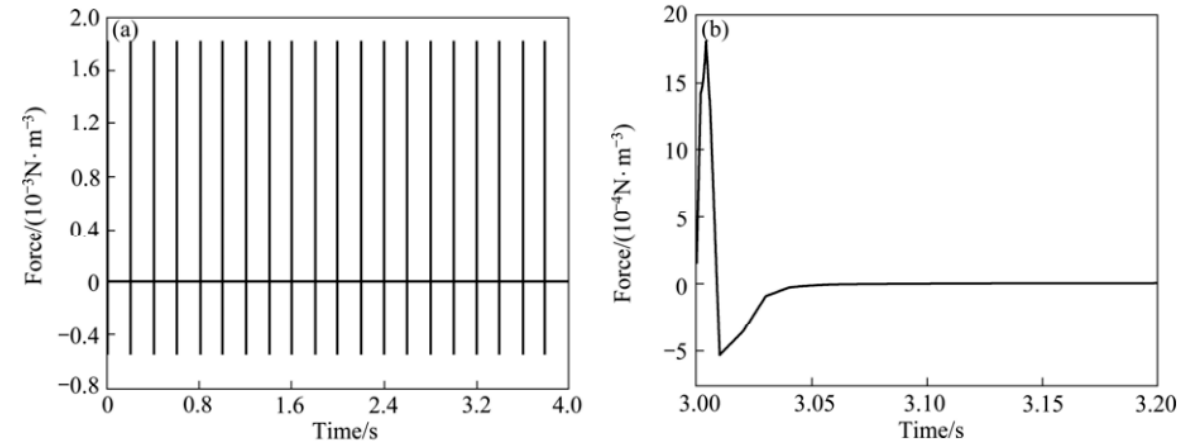
Figure 25. Curves of magnetic force of node at external center of melt: ( a ) 20 whole periods; and ( b ) change of magnetic force in upward period and falling period of pulse [22].